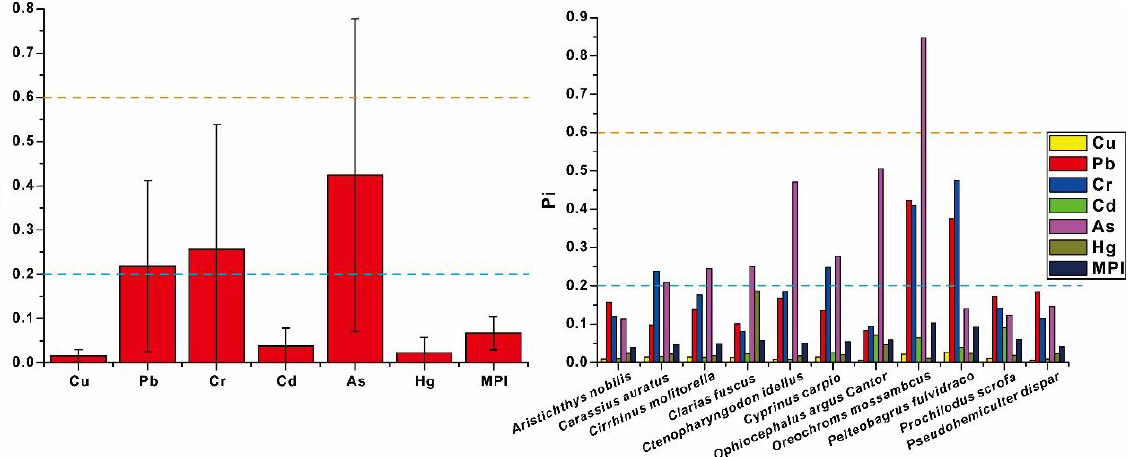
Figure 2. The contamination of metals in angling fish of Guangzhou City. Note: The blue and yellow dotted lines are, respectively, the threshold of low contamination and moderate contamination.